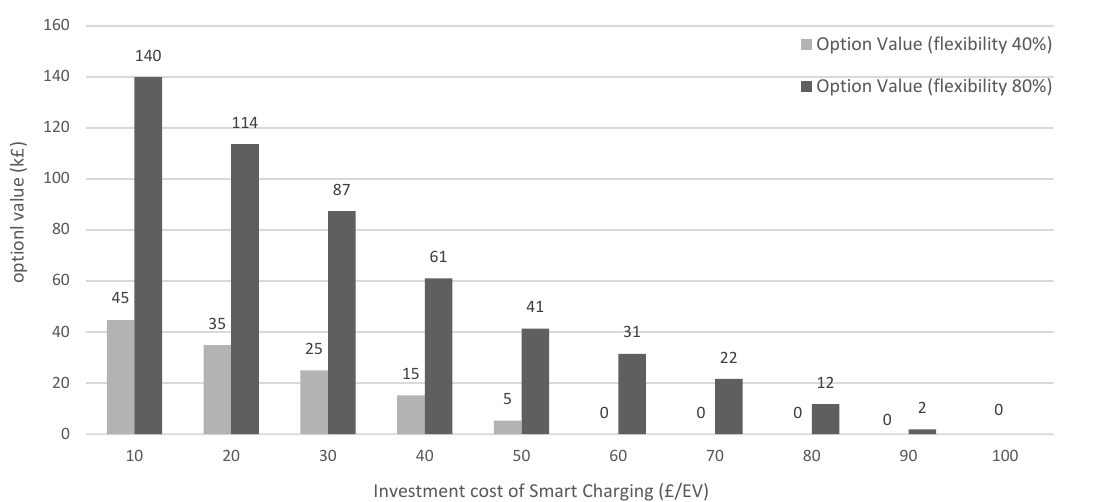
Figure 17. Optimal total expected system cost as a function of scenario probabilities, under SOF and BIF.